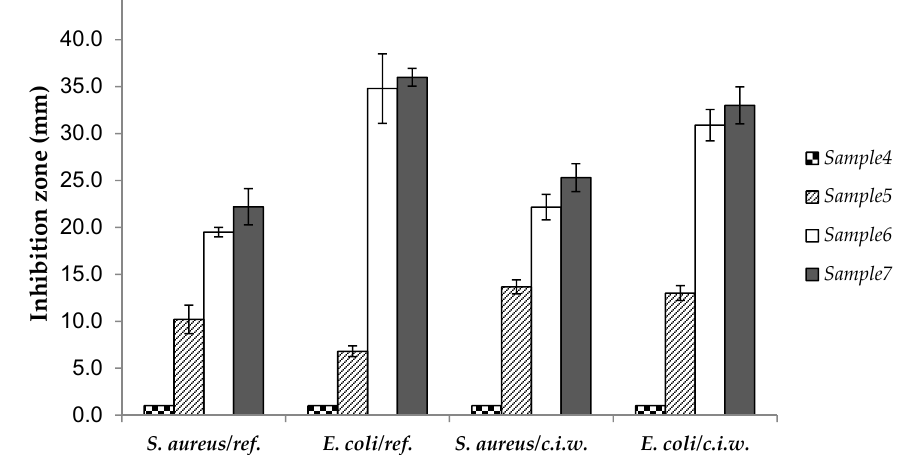
Figure 5. A representative graph comparing the antibacterial activity of the ciprofloxacin-bismuth (Cip-Bi) dressing samples: Sample 4 (bromine-activated, hydrogel-loaded dressing); Sample 5 (iodine-activated, hydrogel-loaded dressing); Sample 6 (bromine-activated, Cip-Bi hydrogel-loaded dressing); Sample 7 (iodine-activated, Cip-Bi hydrogel-loaded dressing) against the tested, reference (ref.) and clinical strains of bacteria (c.i.w.—clinical isolates from infected wounds) .